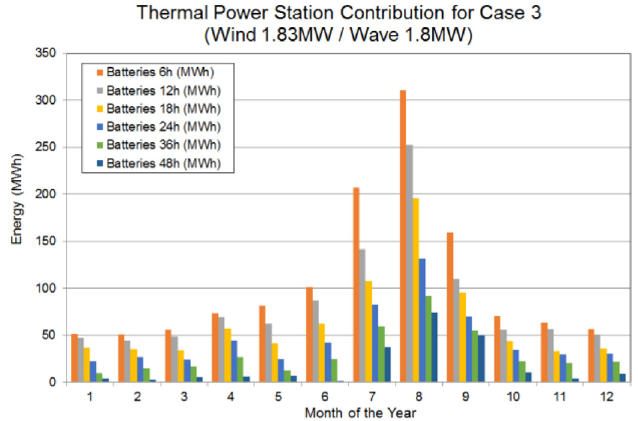
Fig. 16. Monthly oil-based energy production for the local APS vs. storage scenarios of case 3.